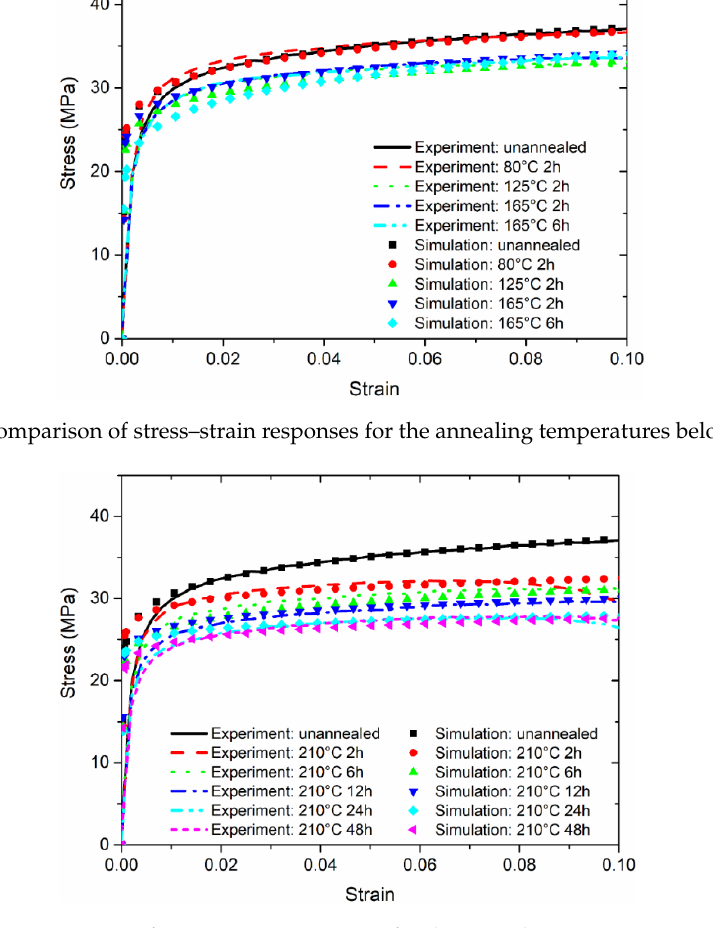
Figure 10. Comparison of stress–strain responses for the annealing temperatures at 210 °C.